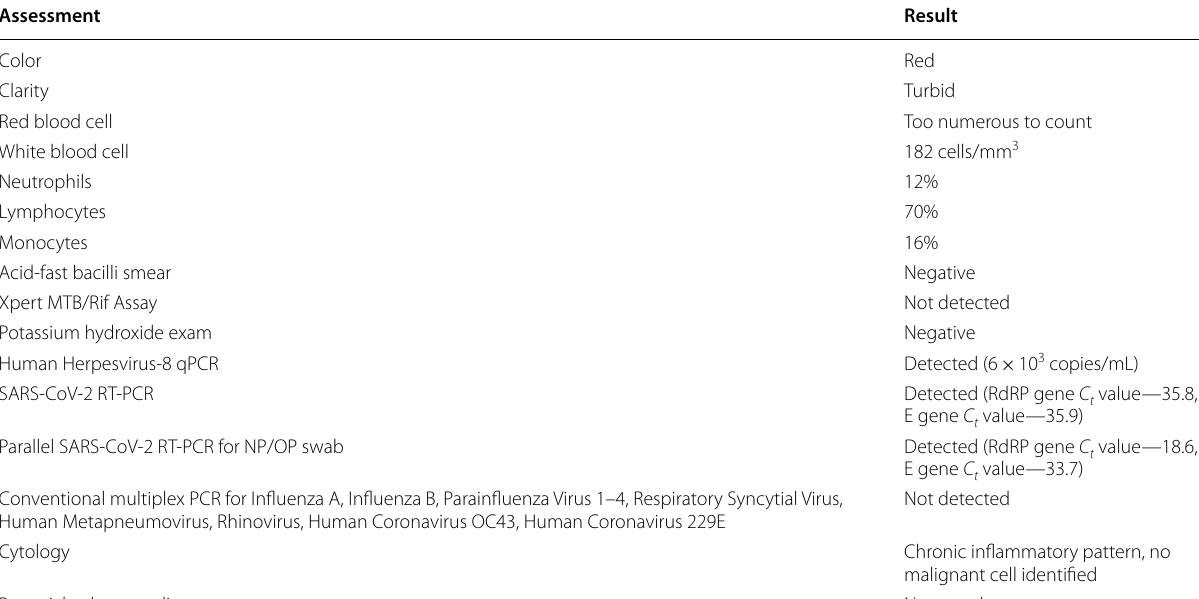
Table 1 Pericardial fluid analysis